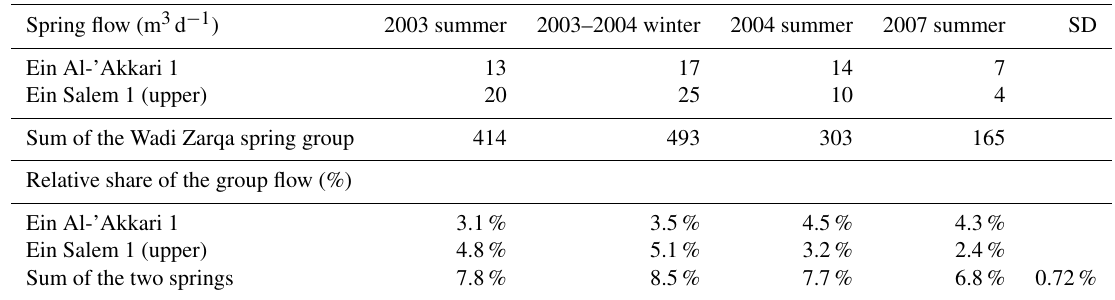
Table F2. Comparison of spring discharge (and the standard deviation) between daily measured springs and the entire Wadi Zarqa spring group during key date